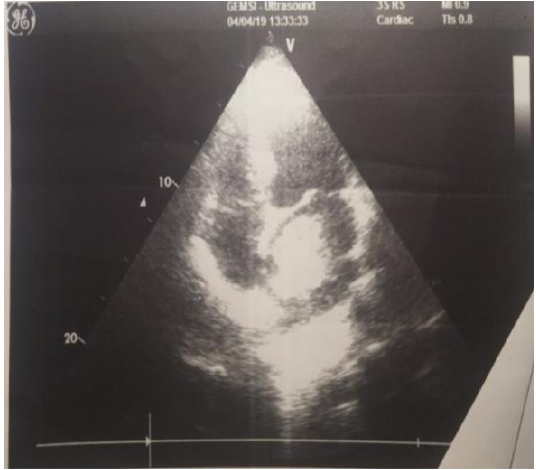
Figure 1: Echographic photo of left atrial myxoma